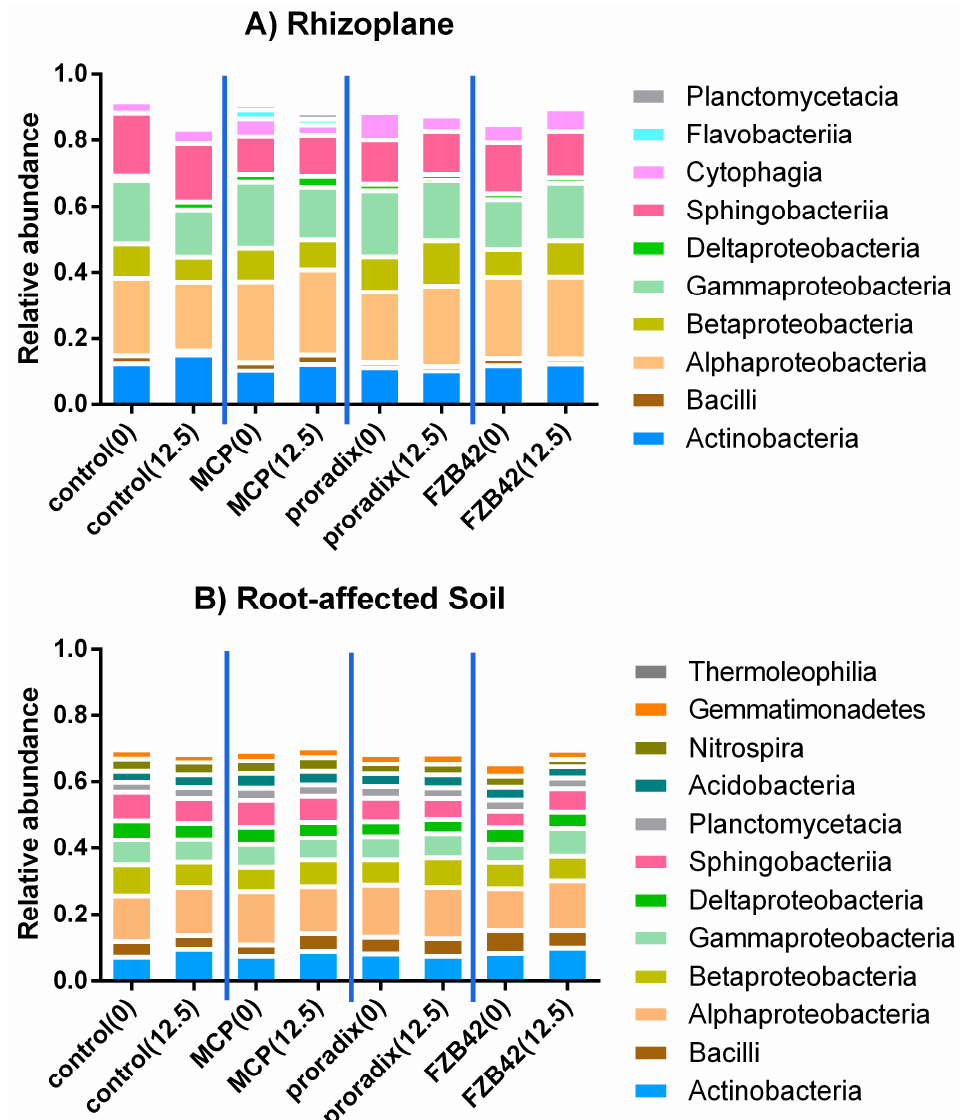
Figure 6. Relative abundance of different bacterial taxa at the rhizoplane ( A ) and in the root-affected soil ( B ) of drip-irrigated tomato plants with and without band placement of triple superphosphate (12.5 kg P ha − 1 ) and inoculation with different microbial BS at 6 months after sowing, Negev, Ramat, Israel.